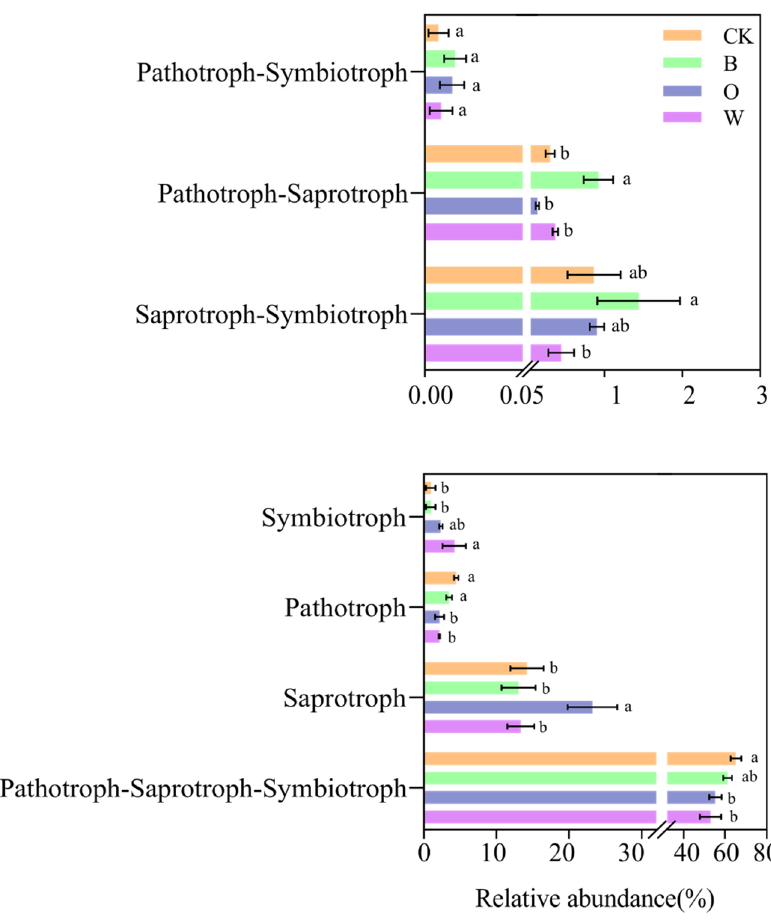
Figure 9. Soil fungal function prediction of soil in different treatments (Hierarchy Level 1). CK represents Chinese cabbage continuous cropping, B, O, and W represent bean, potato onion, and wheat rotation respectively. Different letters are significantly different ( p < 0.05, Tukey’s HSD test).